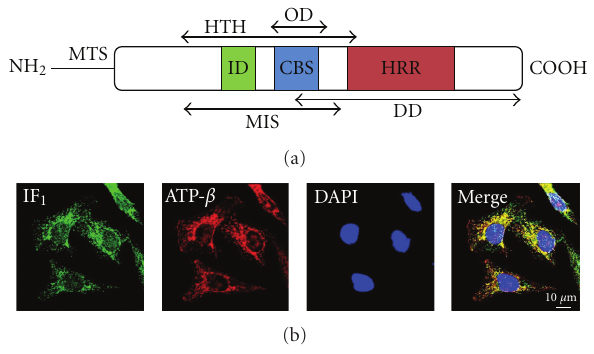
Figure 2: IF 1 : structure and intracellular localization. (a) Schematic representation of bovine IF 1 . The mature protein is composed of 84 residues and is α -helical along most of its length; an amine-terminal presequence of 25 aminoacids represents the mitochondrial target- ing sequence (MTS) required for the tra ffi cking of IF 1 into the mito- chondrial matrix. In complex, IF 1 shows an ordered N -terminal region, which adopts a helix-turn-helix structure (HTH: residues 14–50) and is flanked by two disordered regions. The inhibitory domain (ID) is located at the N -terminus and is part of the minimal inhibitory sequence (MIS: residues 14–47) necessary for a correct interaction with the F 1 domain of the ATP synthase. A calmodulin- binding site (CBS: residues 33–42) have been identified at positions 33–42, followed by a histidine-rich region (HRR: residues 48–70) which is implicated in the pH-sensing mechanism and hence in the dimerization. The dimerization of IF 1 depends on the C -terminal region, which hosts the dimerization domain (DD: residues 37– 84), while the oligomerization domain (OD: residues 32–44) is located in the N -terminal region of the protein, so that after oligomerization the inhibitory domain is hidden and the protein inactivated. (b) Immunocytochemical localization of IF 1 in HeLa cells: the preferential mitochondrial matrix compartmentalization of the protein is shown by its colocalization with the ATP synthase. Cells were costained with anti-IF 1 and anti-F 1 F o -ATPsynthase β chain antibodies, while DAPI was used for nuclear